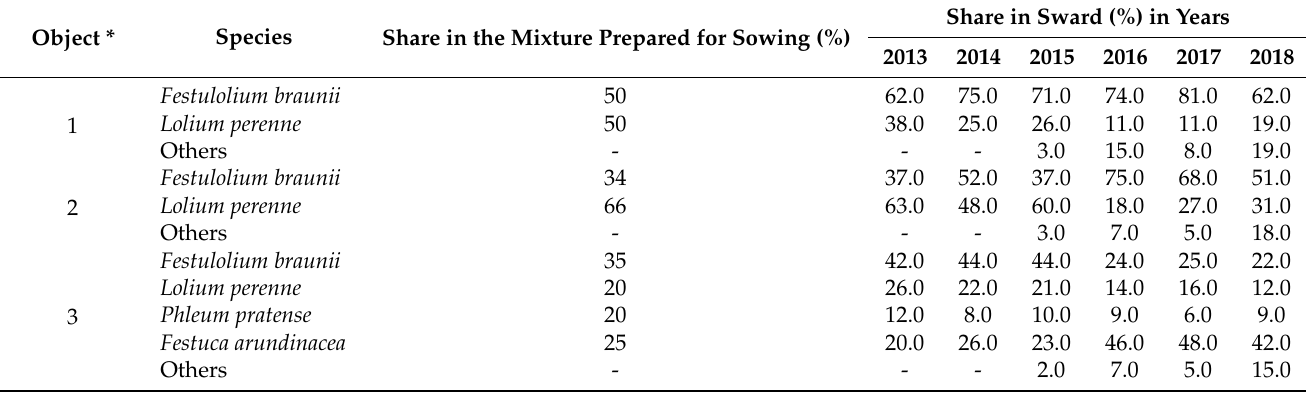
Share in Sward (%) in